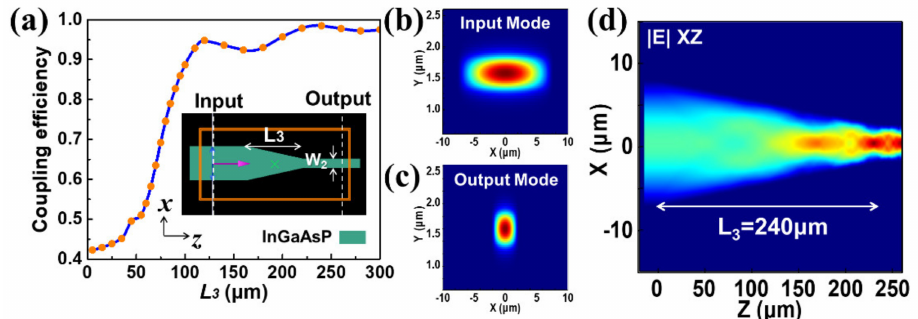
Figure 5. ( a ) The mode connection efficiency between the 15- µ m wide waveguide and the 4- µ m wide waveguide as a function of the taper length L 3 . The taper loss at L 3 = 240 µ m was 1.5%. ( b ) Simulated 2D profile of the input mode. ( c ) Simulated 2D profile of the output mode. ( d ) Horizontal cross-section illustrating the behavior of the propagating beam in the taper with L 3 = 240 µ